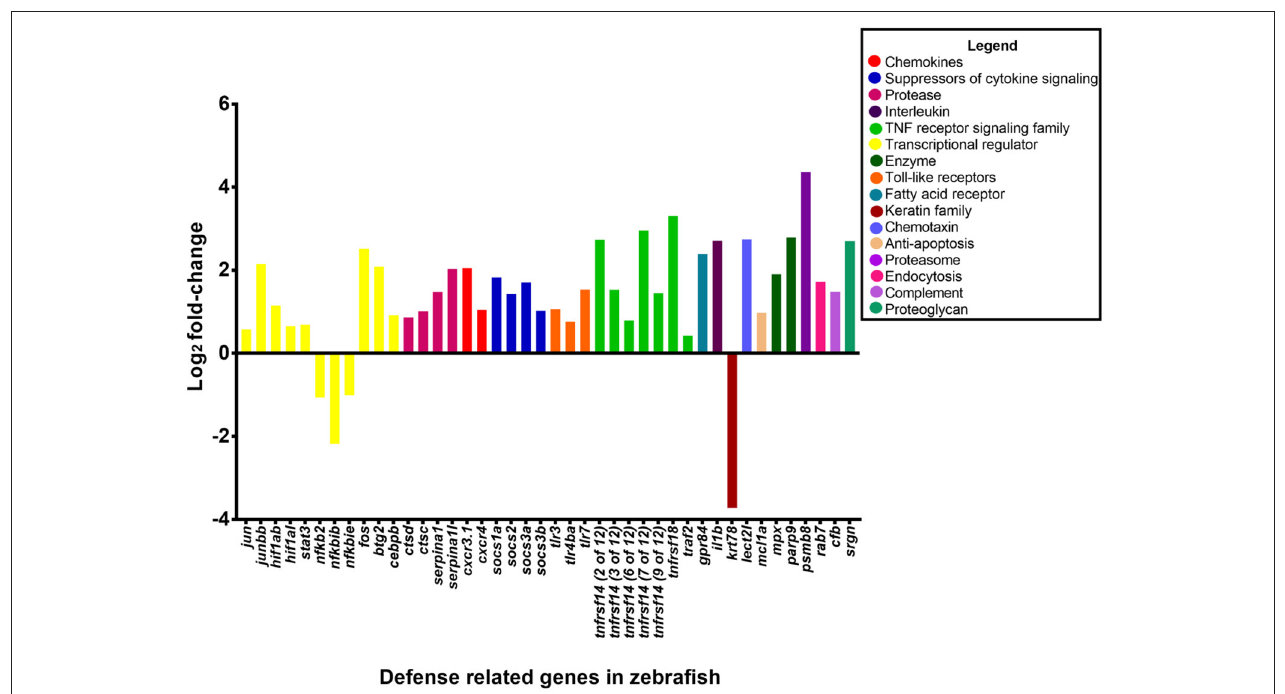
FIGURE 6 | Expression of host defense-related genes in response to infection with P. aeruginosa PASS1. The upregulated genes in zebrafish infected with PASS1 ( p ≤ 0.01 and log 2 fold-change cut-off − 1 ≥ to ≤